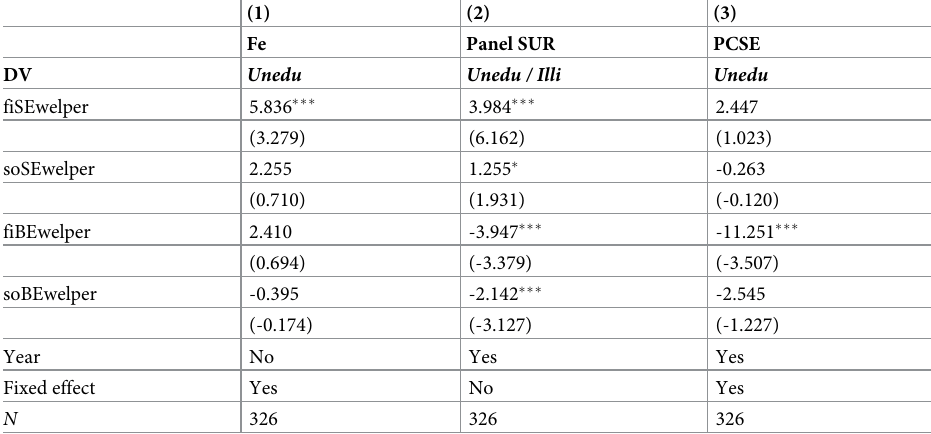
Table 5. The results of welfare expense on RSE